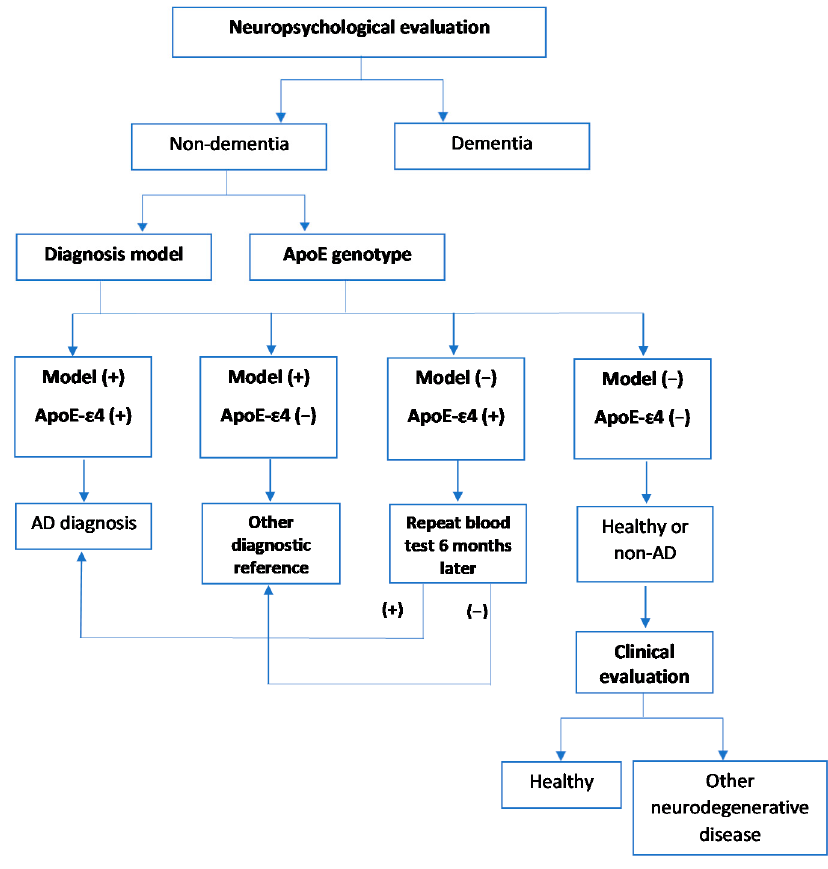
Figure 1. Decision tree as screening approach in early and differential AD diagnosis. Table 4. Prediction effect of the model and genotype.